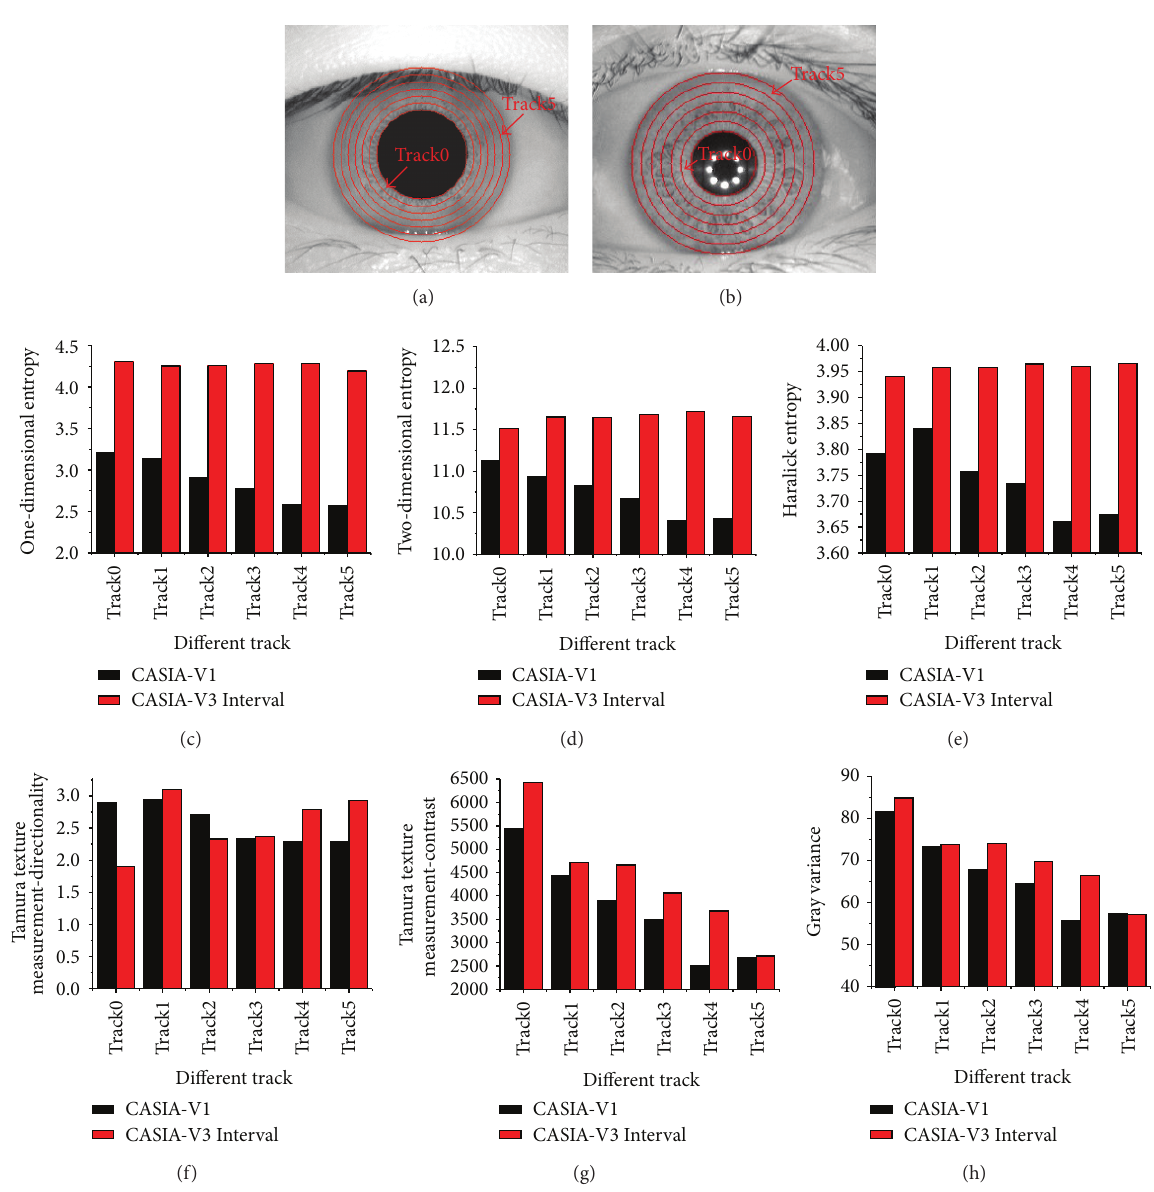
Figure 6: Bar chart of image quality evaluation. (a) CASIA-V1 image, (b) CASIA-V3 Interval image, (c) one-dimensional entropy, (d) two- dimensional entropy, (e) Haralick texture entropy, (f) Tamura texture directionality measurement, (g) Tamura texture contrast measurement, and (h) gray